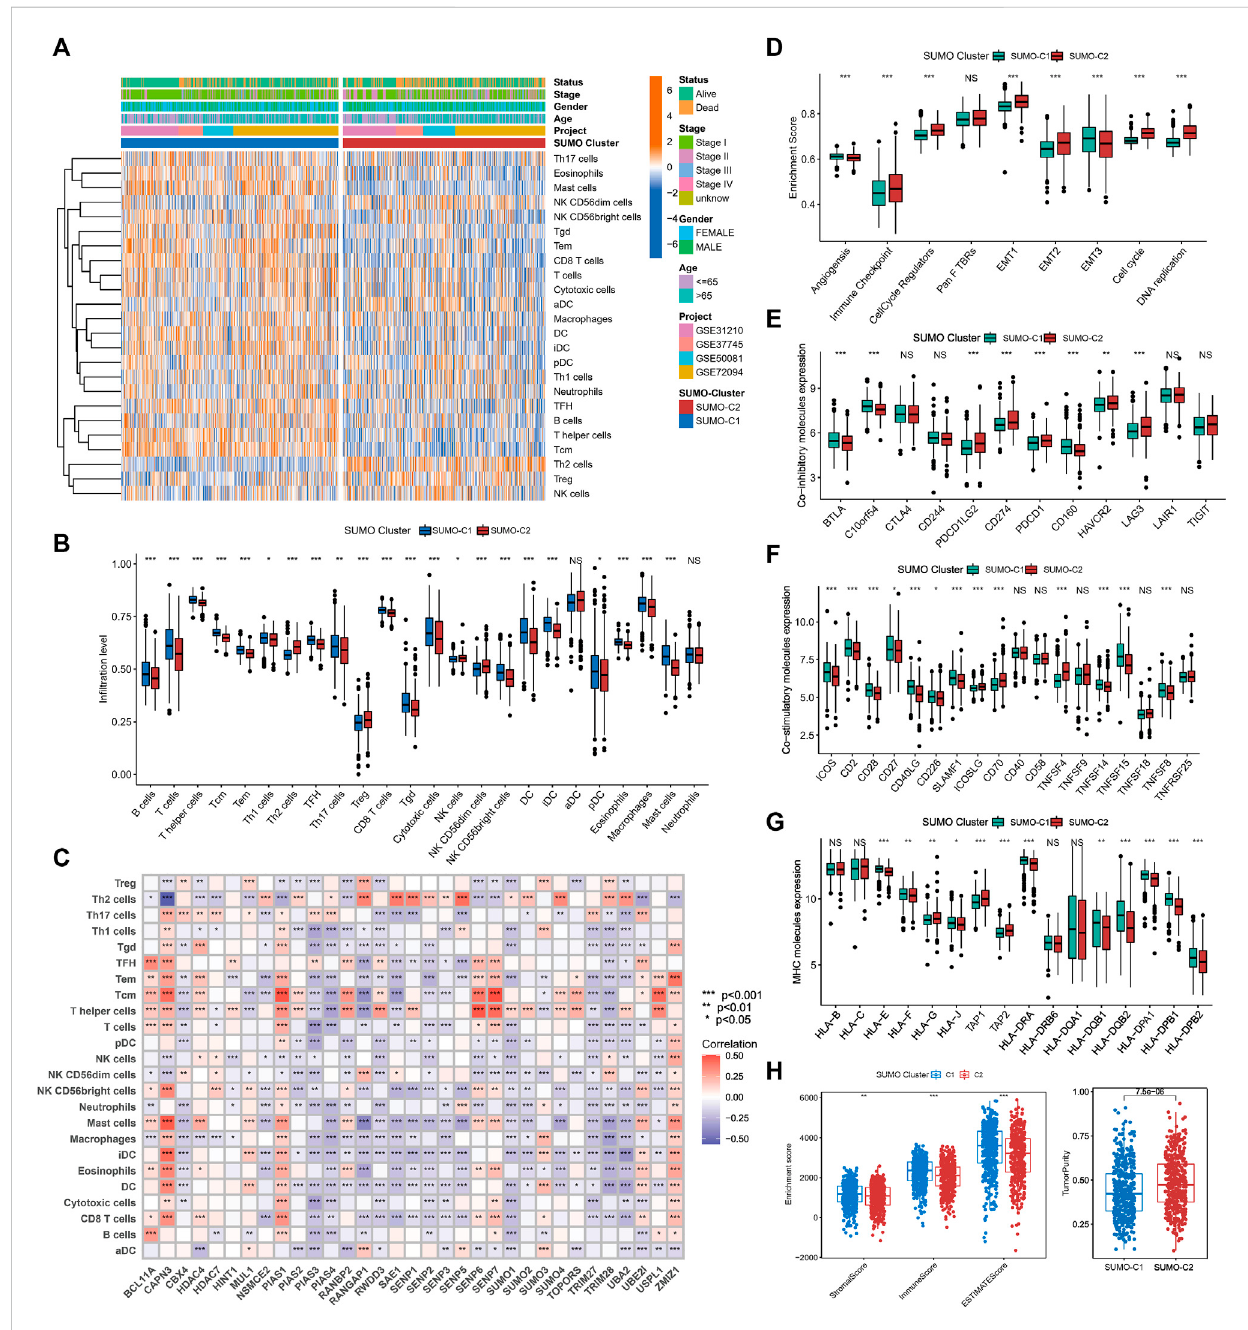
FIGURE 4 The tumor microenvironment differs signi fi cantly between SUMOylation patterns. (A) The heatmap shows the GSVA scores of 24 immune cells among two SUMOylation patterns in lung adenocarcinoma. Annotated with Status, Smoking History, Stage, Gender, Age, GEO cohort, and SUMOylation patterns. Orange is high expression and blue is low expression. (B) Wilcoxon test for differences in GSVA scores of 24 immune cells in two SUMOylation models. (C) Correlation between 33 SUMOylation regulatory genes and immune in fi ltrating cells using Spearman analysis. (D) Differences in oncogenicmatrixmicroenvironmentbetweentwoSUMOylationpatterns. (E) Signi fi cantlydifferentialexpressionofco-inhibitorymoleculesbetweenthe two SUMOylation patterns. (F) Differential expression of co-stimulatory molecules and (G) MHC molecules between two SUMOyaltion patterns. (H) Wilcoxon test for differences in immune scores, stromal scores, and tumor purity between the two SUMOylation